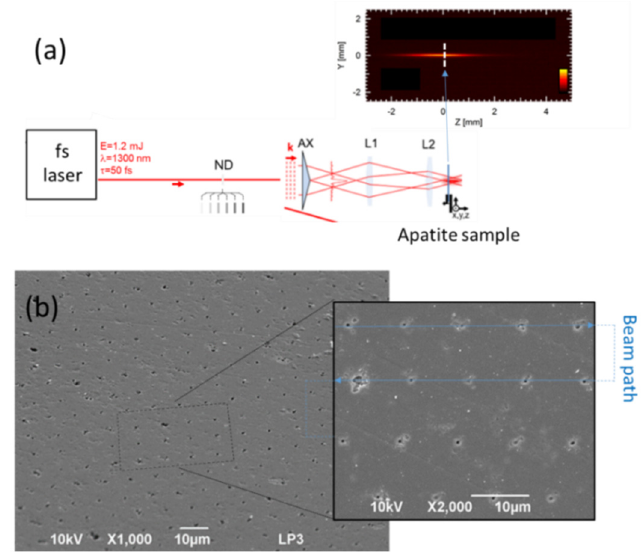
Figure 5. Periodically micro-structured stoichiometric sintered hydroxyapatite surface by direct femtosecond laser ablation. ( a ) Experimental arrangement for localizing laser radiation on a sample surface with micrometer size resolution over an extended depth of field. This allows to rapidly scan a large area of the sample with the beam to directly produce an array of identical craters. AX is a low-angle axicon producing a Bessel laser filament miniaturized with a 4-f imaging system provided by two lenses: L1 and L2. The inserted top image is a plasma luminescence in air evidencing the delivery of a high-intensity small filament extending over millimeters along the optical axis. ( b ) SEM images (tilted general view and zoomed top-view) illustrate the level of control that can be obtained. The periodicity is controlled with the scan speed and femtosecond laser repetition rate.